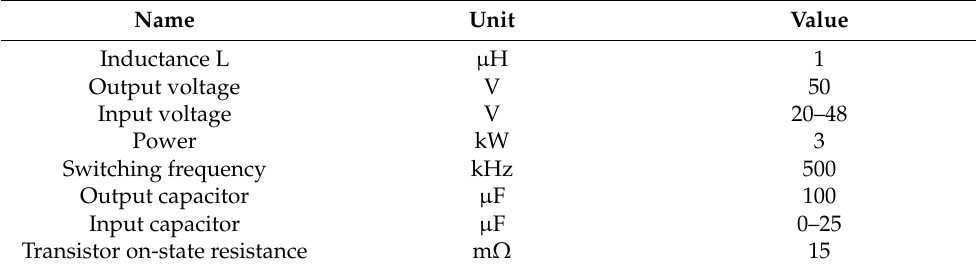
Figure 35. SC energy storage consisting of 20 20 Maxwell BCAP0450 P270 S18 supercapacitors. Table 1. Main parameters of the DC–DC